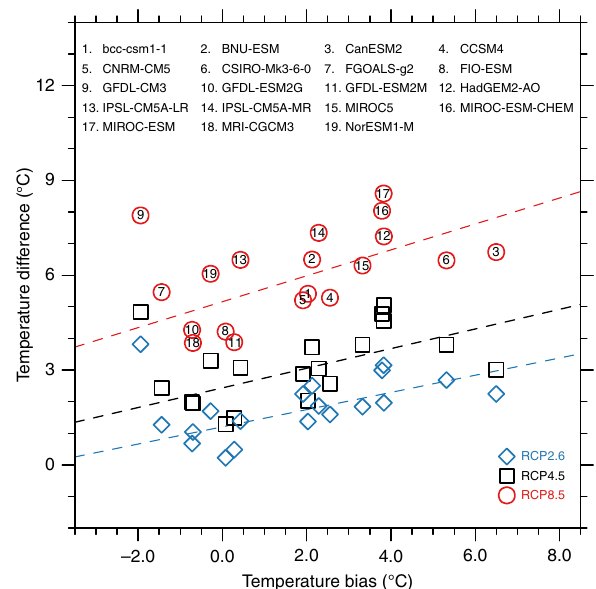
Fig. 5 Relationship between temperature changes and temperature bias. The relationships between temperature changes (2080 – 2099 relative to 1981 – 2000) and temperature bias for the three RCP scenarios. RCP2.6, RCP4.5, and RCP8.5 are represented by blue, black, and red symbols. Dash lines indicate the linear fi t to each scenario excluding model 9. Numbers with circle represent the correspondent models. The regression equations for the three RCP scenarios are: δ T ¼ 0 : 27 T bias þ 1 : 20 r 2 ¼ 0 : 54 ; P < 0 : 01